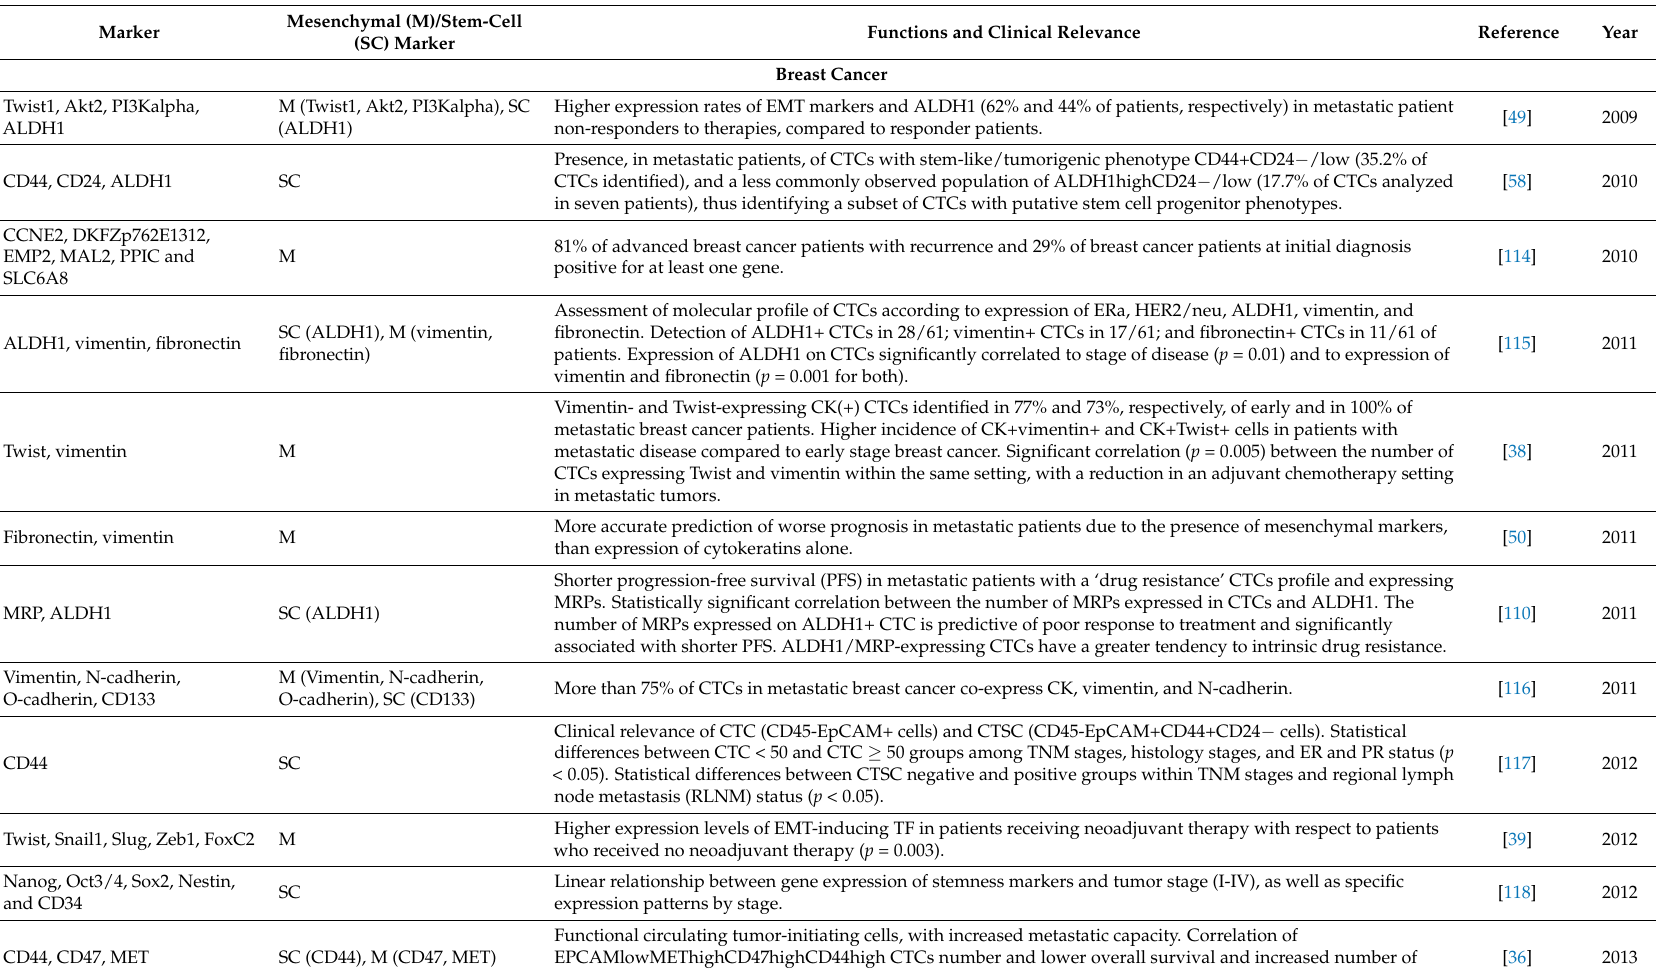
Table 1. List of the most relevant mesenchymal and stemness markers for CTCs